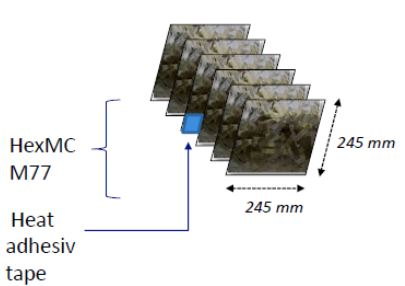
Figure 3. Composition of plate for fracture mechani- cal